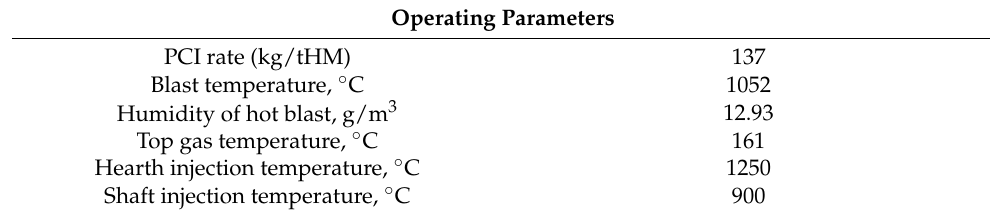
Figure 1. Blast furnace process with CO 2 capture, conversion, and H 2 -rich gas injection. Table 1. Operating conditions of the simulation.